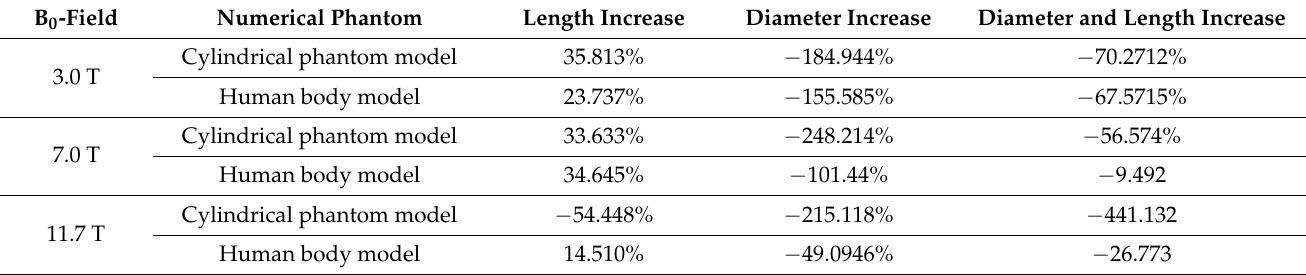
Table 4. The variations of RF transmission efficiency according to the change in diameter or length of Hybrid-BC RF coil in a 3.0, 7.0, or 11.7 TRI